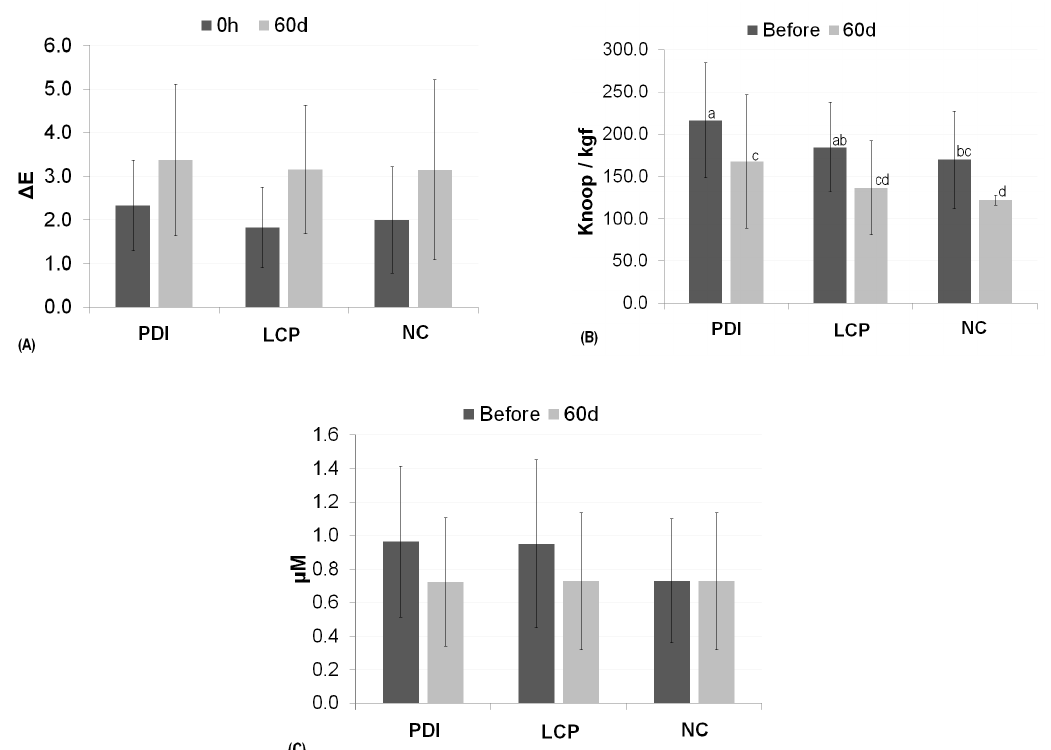
Figure 5. Mean and standard deviation for color changes ( A ), surface microhardness ( B ), and surface roughness ( µ M) ( C ), obtained on tooth enamel surfaces following treatment (PDI: curcumin-mediated photodynamic inactivation in a liquid crystal precursor system; LCP: only the liquid crystal precursor system without curcumin; NC: negative control with no treatment; only artificial saliva) at the different evaluation times. ‘0 h’ indicates color evaluations performed immediately after treatments; ‘Before’ indicates evaluations performed before treatments, and ‘60 days’ indicates evaluations performed after 60 days of treatment (stored in artificial saliva). In the chart labeled ( A ): Mixed ANOVA: time ( p < 0.001); treatment ( p = 0.444); time × treatment ( p = 0.852). In the chart labeled ( B ): Mixed ANOVA: time ( p < 0.001); treatment ( p < 0.001); time × treatment ( p = 0.996). Šidák correction ( p correctio Columns marked with different lowercase letters (a, c, ab, cd, bc, and d) indicate a statistically significant difference among means according to Sid á k correction. In the chart labeled ( C ): Mixed ANOVA: time ( p = 0.002); treatment ( p = 0.364); time × treatment ( p =